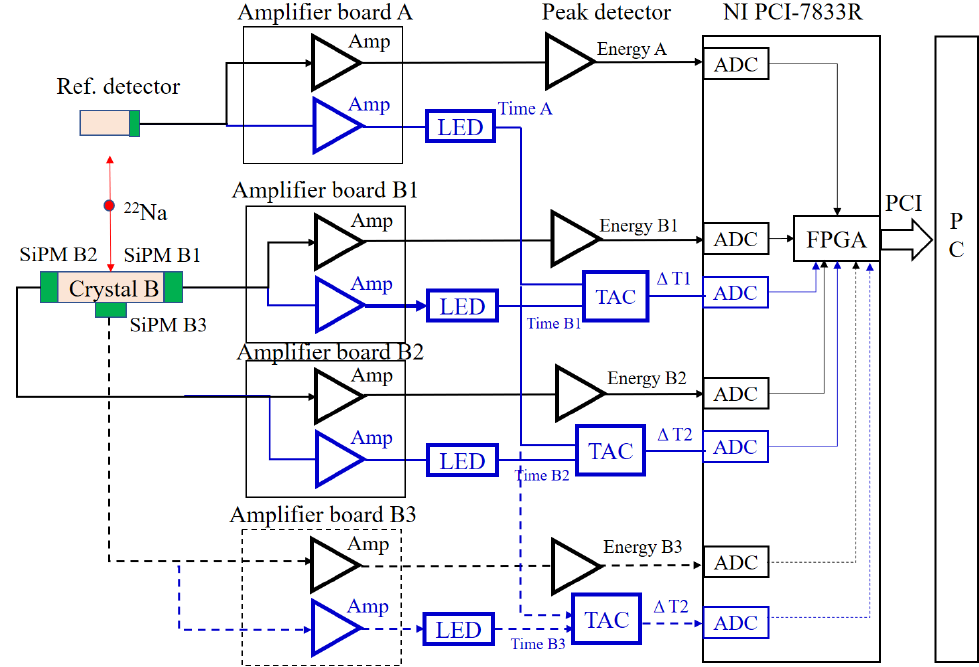
Figure 4. The diagram of the readout electronics system.